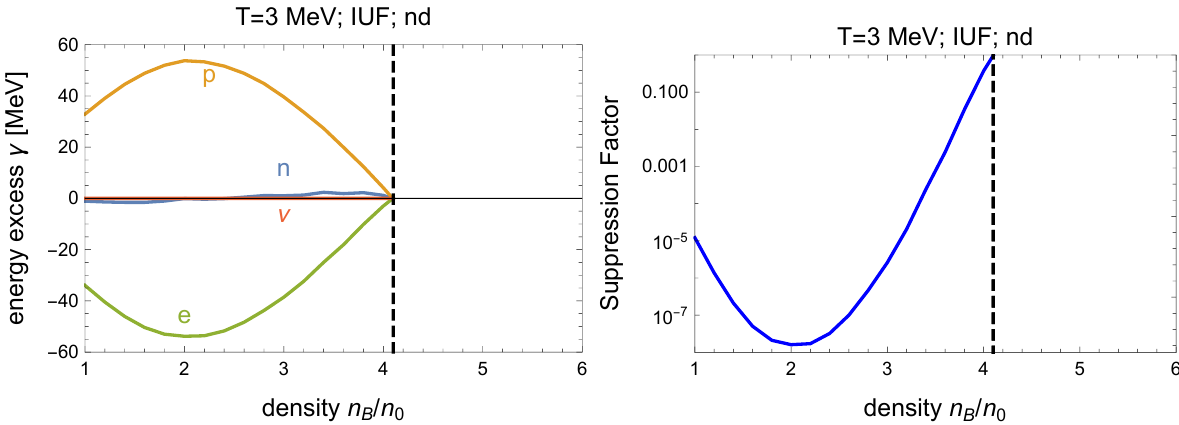
Figure 11. The optimal kinematics for neutron decay for the IUF EoS. Left panel : the least suppressed kinematic arrange- ment, showing the energy distance γ of each particle from its Fermi surface. Right panel : the Fermi-Dirac suppression factor, e −| γ e | / T e −| γ n | Θ ( γ n ) / T which is dominated by the difficulty of finding an electron hole at energy γ e below its Fermi